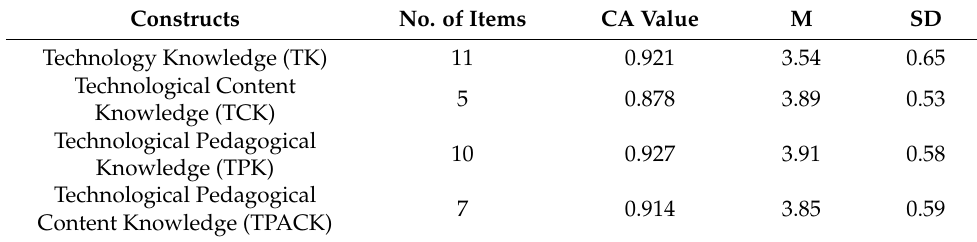
Table 2. Reliability